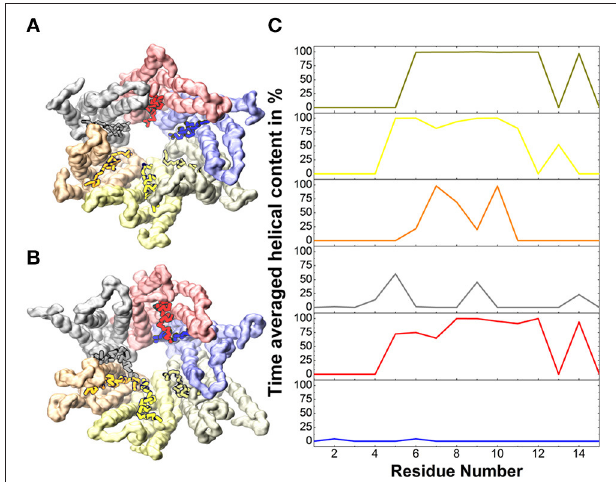
FIGURE 2 | Helical content in the N-terminal helices. (A) Solvent accessible surface of the backbone beads of the Cx26 Connexon colored by chain for the initial conformer. (B) Same as (A) for the final conformer after 5 µ s. Vivid colors indicate residues 1 to 14 on which the averaged helical content is calculated in (C)